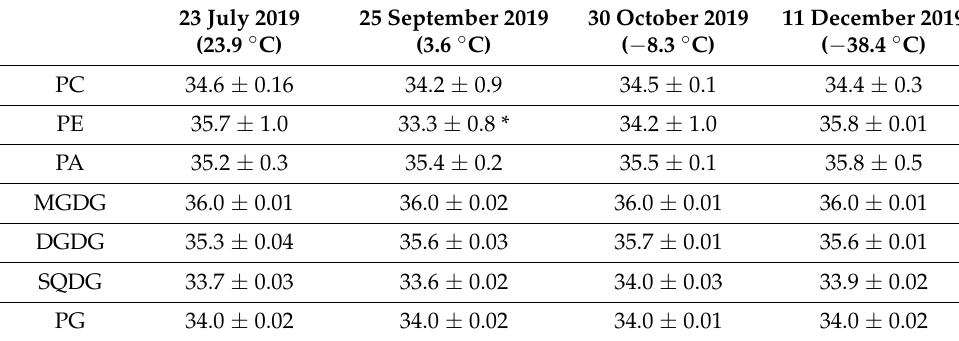
Table 4. Acyl chain length (ACL) of membrane lipids of Ephedra monosperma .